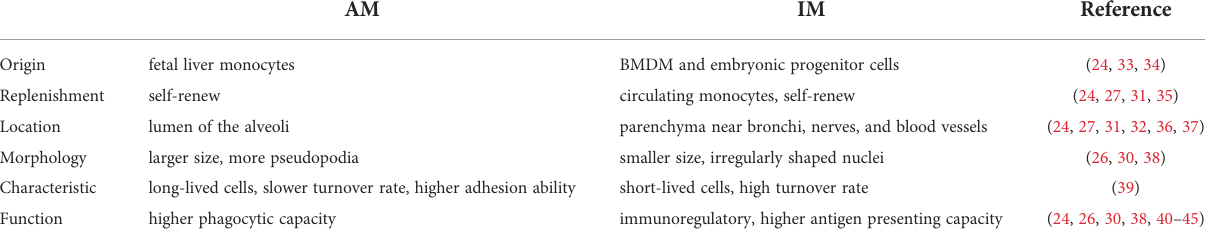
TABLE 2 Properties of AM and IM in steady